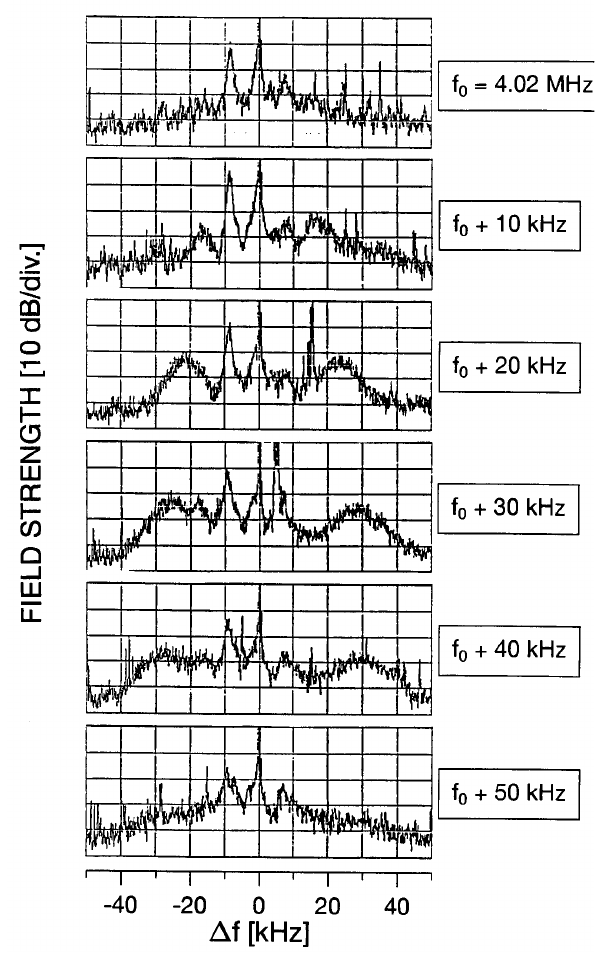
Fig. 8. The behavior of the broad symmetrical structure (BSS) near the third gyroharmonic. These data were taken using the Tromsø HF facility on 9 November 1989, 15:02 to 15:58 UT. Reproduced from Stubbe and Hagfors (1997), Fig. 16.